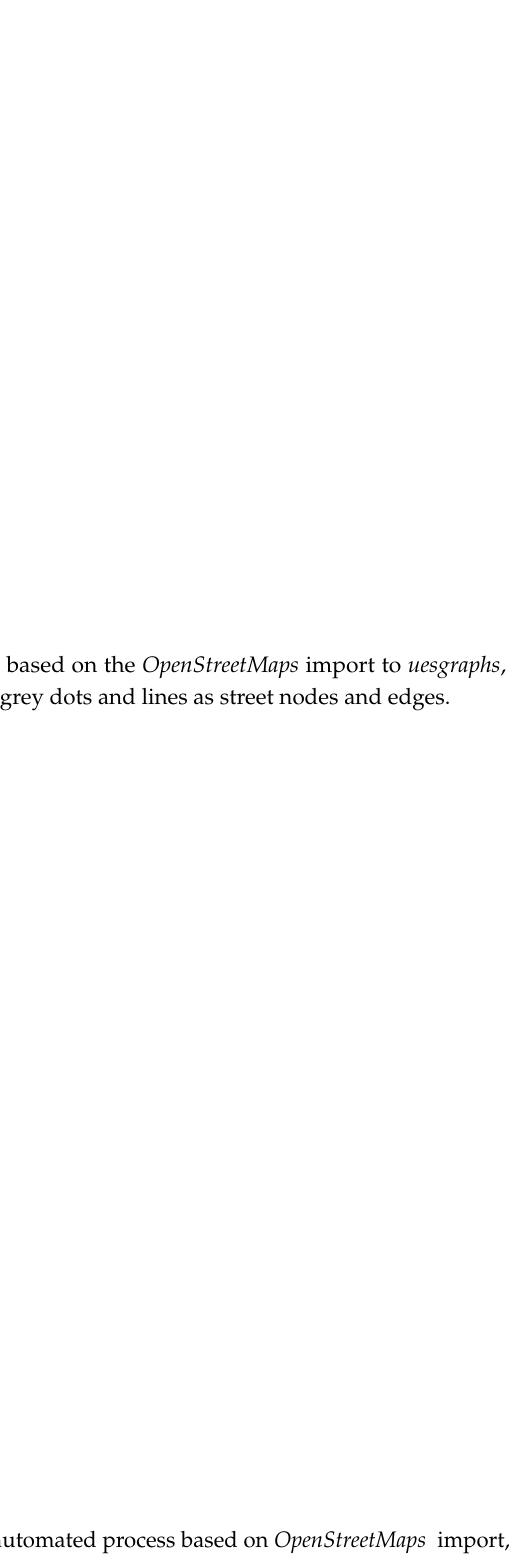
Figure 4. DHC network generated by automated process based on OpenStreetMaps import, showing grey dots as buildings and red dots and lines as network nodes and